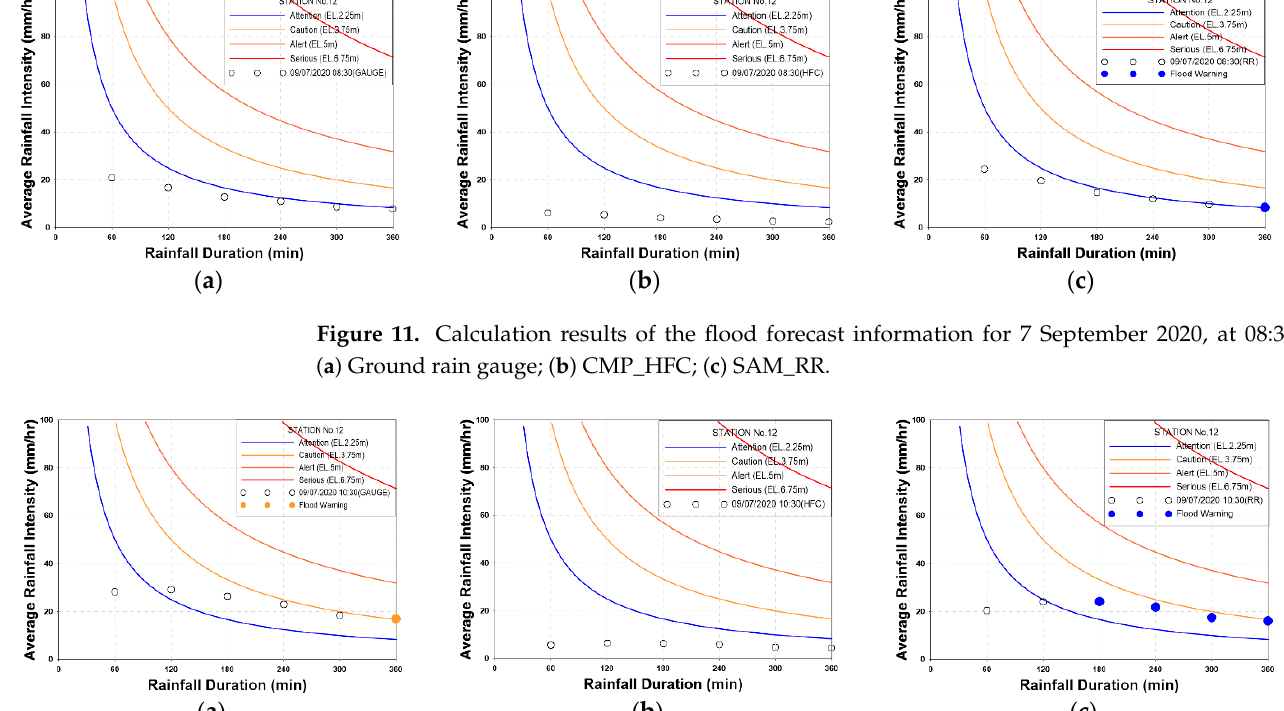
Figure 11. Calculation results of the flood forecast information for 7 September 2020, at 08:30: ( a ) Ground rain gauge; ( b ) CMP_HFC; ( c ) SAM_RR.